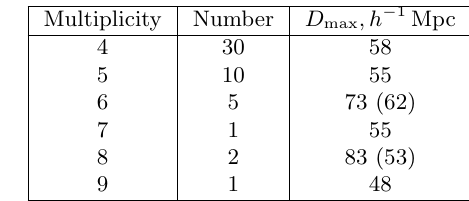
Table 1. Supercluster multiplicity and maximum distance between supercluster members.